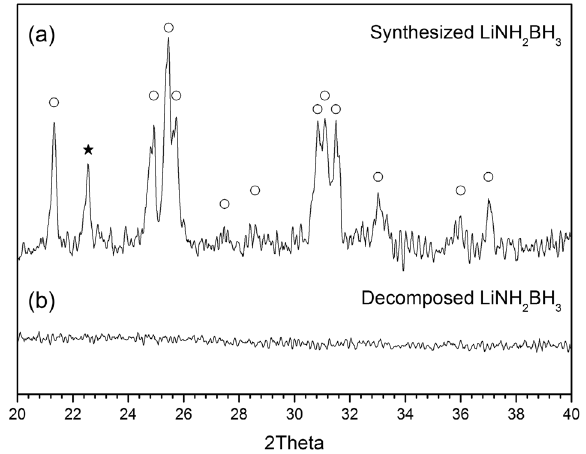
Fig. 1 X-ray diffraction patterns of: a as-synthesized LiNH marked peaks (open circle) for α-LiNH 2 BH 3 and (filled asterisk) for the post-decomposed product of LiNH 2 BH 3 ·NH 3 BH 3 [31]; b amor- phous final decomposition product of LiNH 2 BH